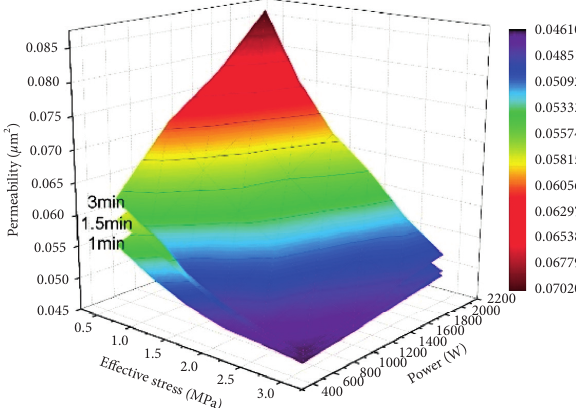
Figure 14: Three-dimensional changes of permeability under axial and confining pressures of